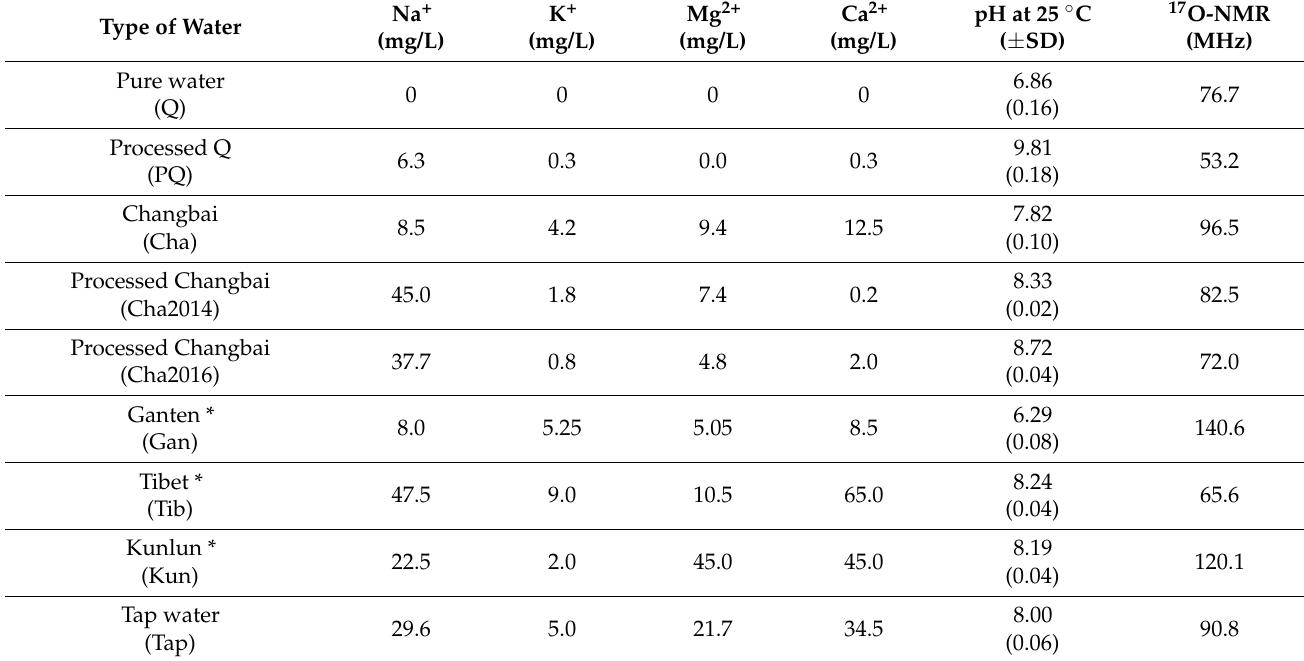
Table 1. Physico-chemical parameters of analyzed water